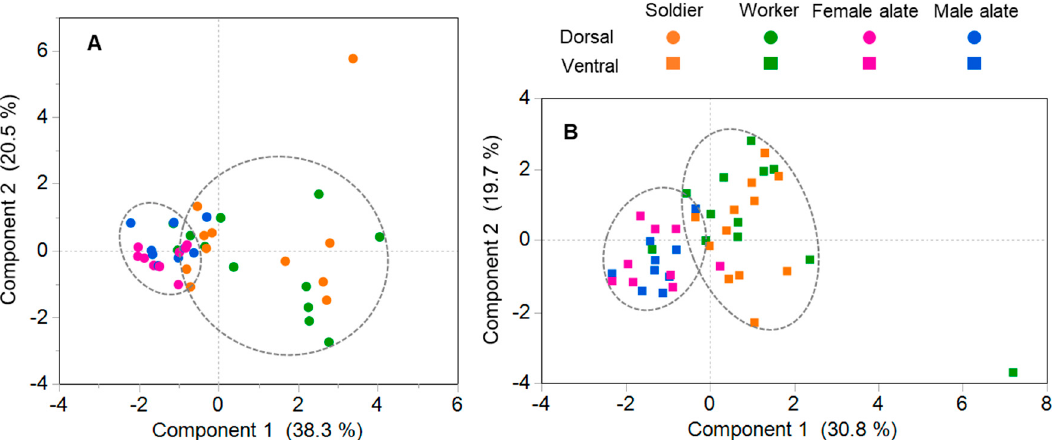
Figure 7. Principal component analysis (PCA) of dorsal ( A ) and ventral ( B ) sensilla in different castes. All nine types of sensilla were included, and percentages of each sensillar type to total sensilla were used in the analysis. The two gray ellipses in each panel encircle approximate 90% samples in the reproductive (female and male alate) and non-reproductive (soldier and worker) castes, respectively. (Dorsal side: n = 11, 12, 9, and 9 for soldier, worker, female and male alate, respectively; Ventral side: n = 12, 12, 9, and 9 for soldier, worker, female and male alate, respectively).